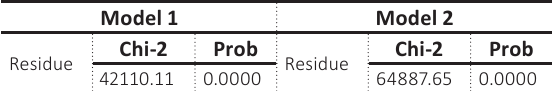
Table 10. Wald test